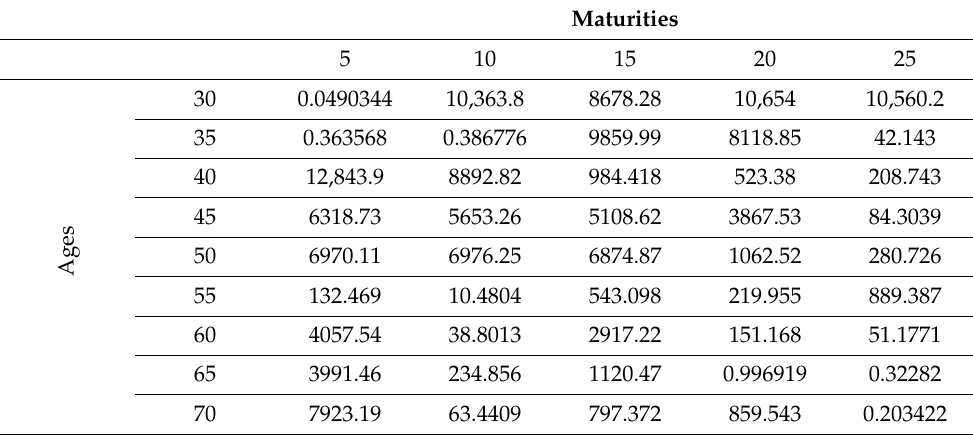
Table 4. Obtained model points portfolio with BH in Example 3. The nominal of each model point is divided by 10 4